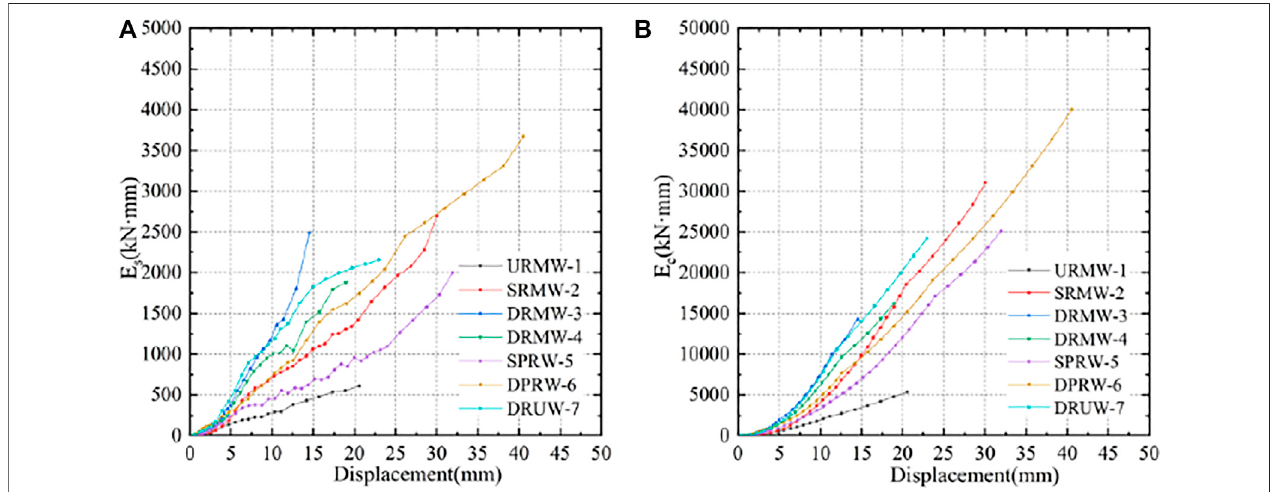
FIGURE 13 | Energy dissipation (A) single-cycle dissipated energy (B) cumulative dissipated energy.